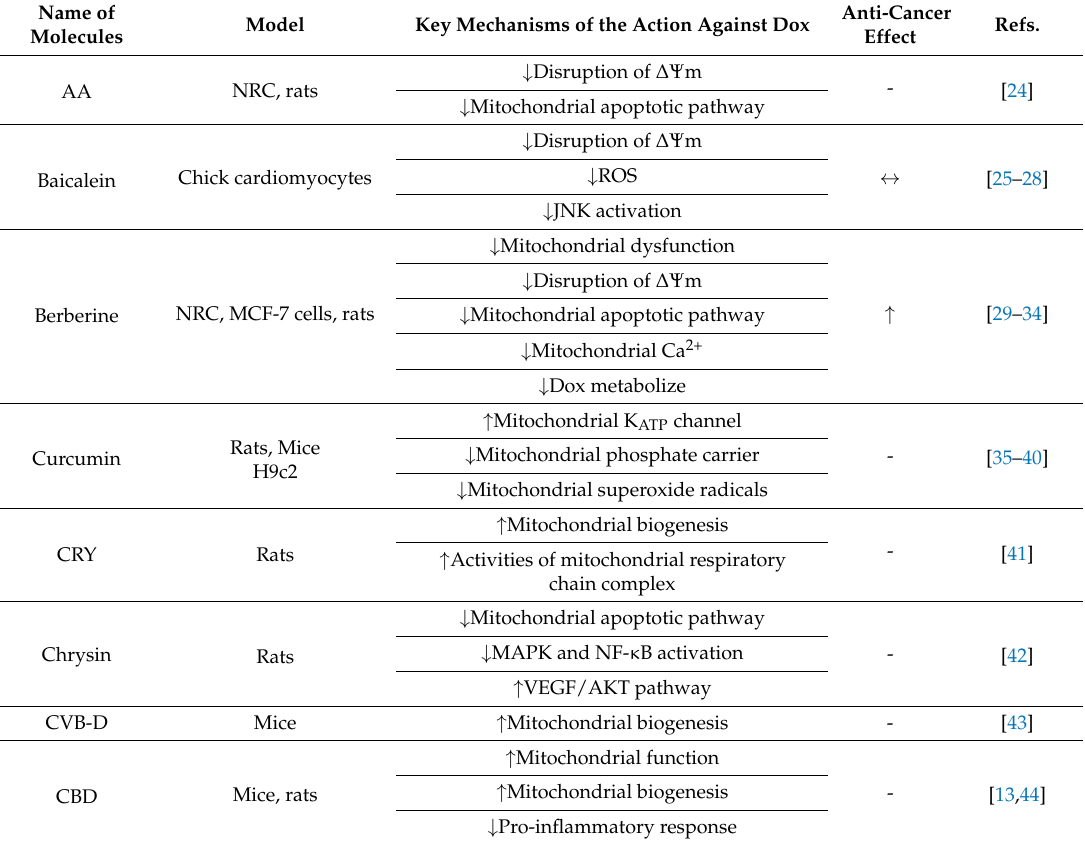
Table 1. Small molecules that target mitochondria effectively prevent the cardiotoxicity induced by